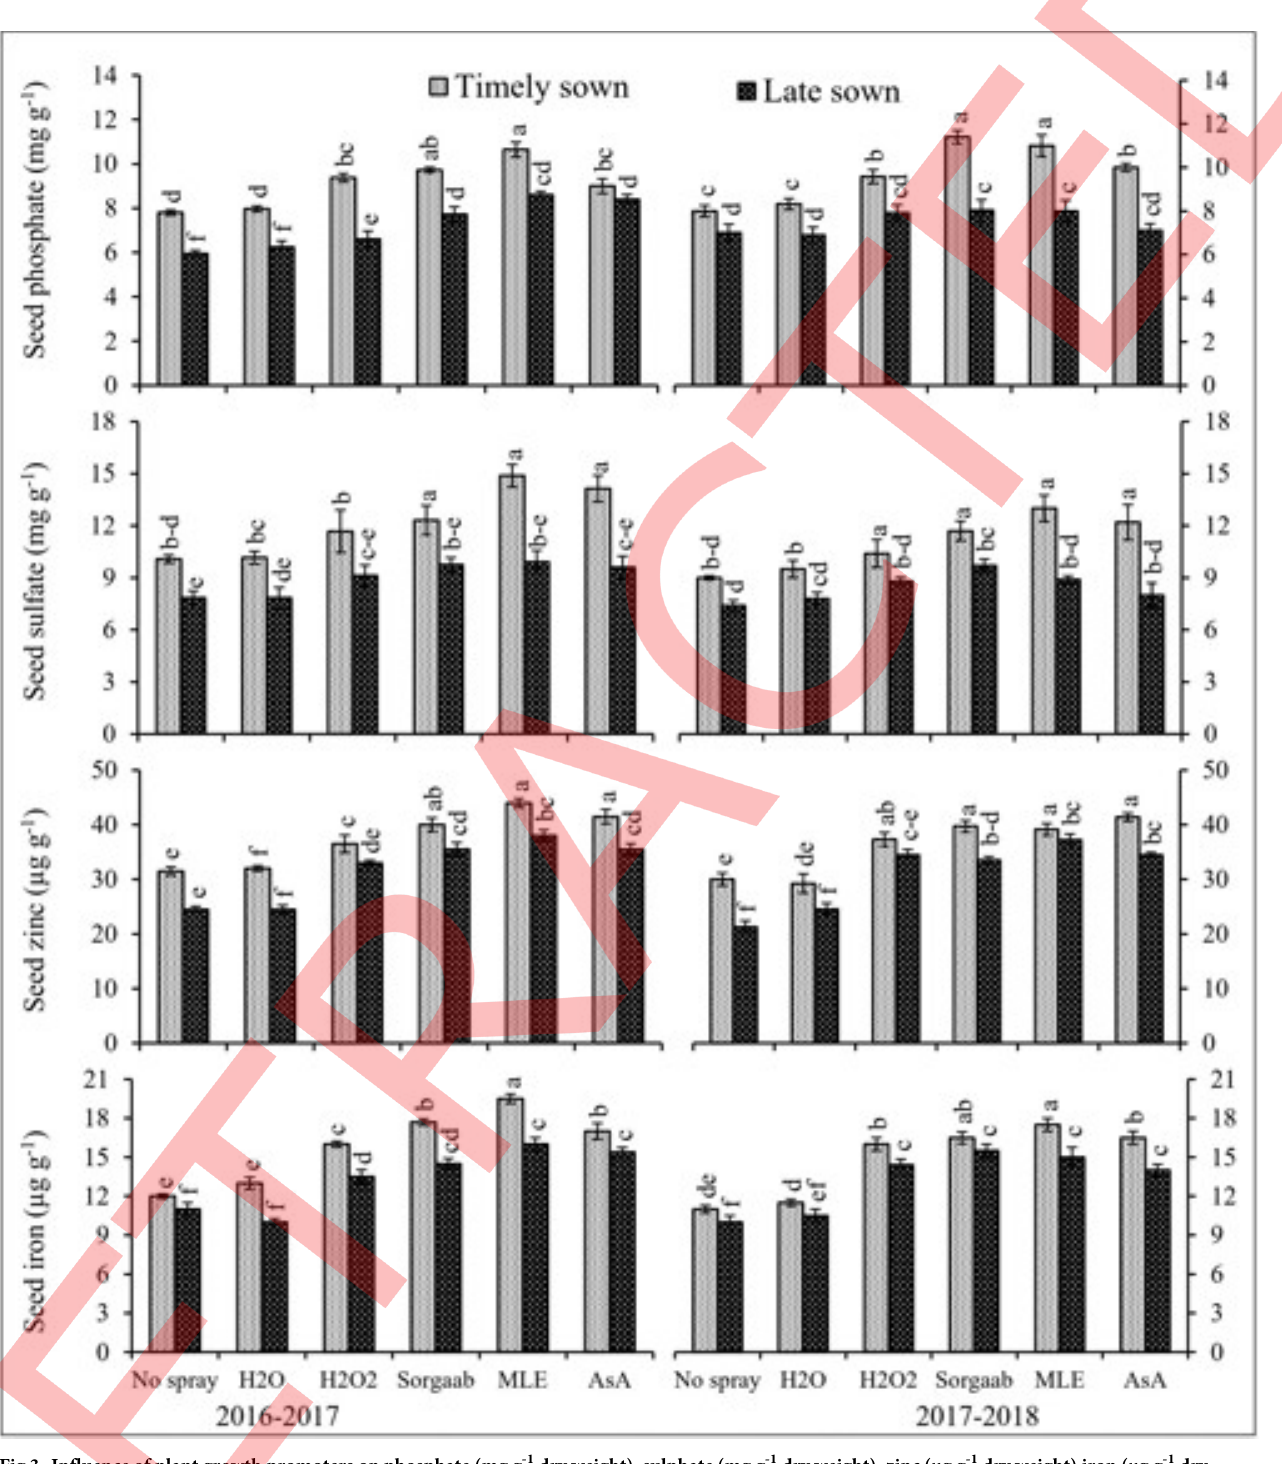
Fig 3. Influence of plant growth promoters on phosphate (mg g -1 dry weight), sulphate (mg g -1 dry weight), zinc ( μ g g -1 dry weight) iron ( μ g g -1 dry weight) contents in seed of quinoa cultivated under timely and late sown conditions during growing seasons of 2016–2017 and 2017–2018.